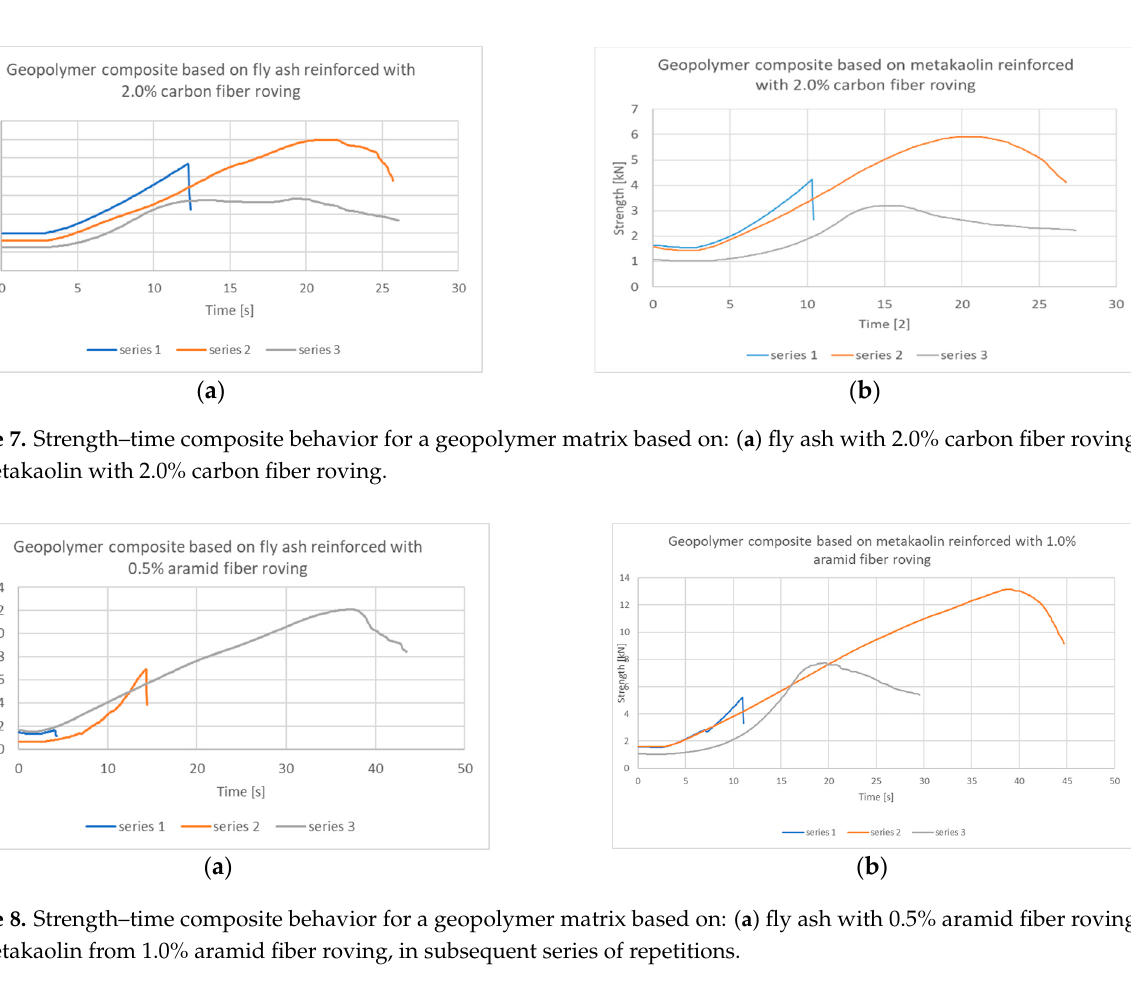
Figure 8. Strength–time composite behavior for a geopolymer matrix based on: ( a ) fly ash with 0.5% aramid fiber roving; ( b ) metakaolin from 1.0% aramid fiber roving, in subsequent series of repetitions.